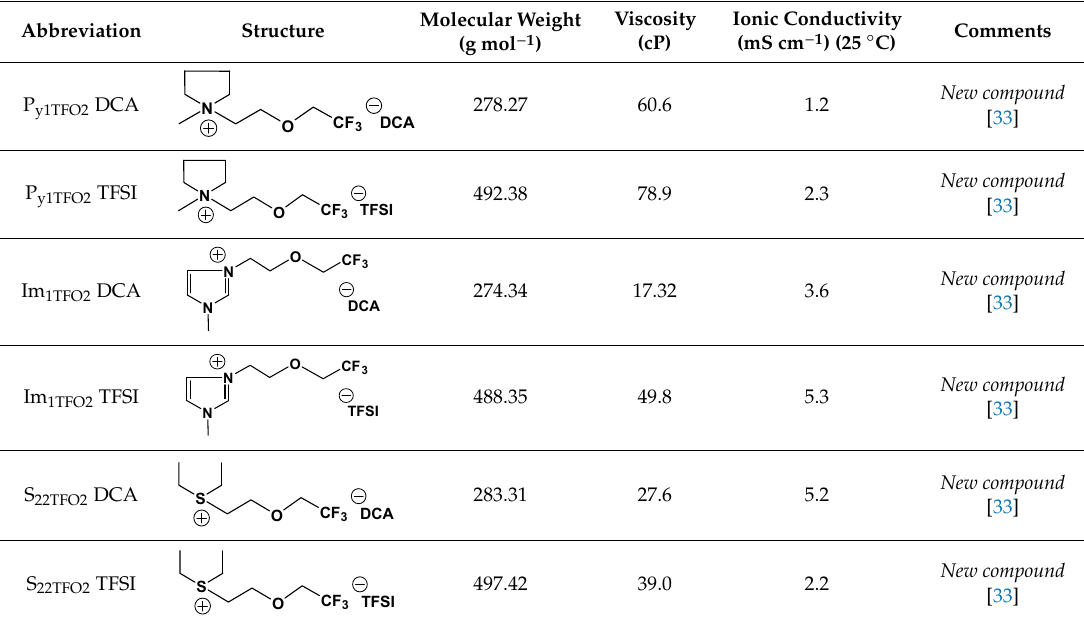
Table 4. Properties of fluorine-containing ionic liquids (FILs).